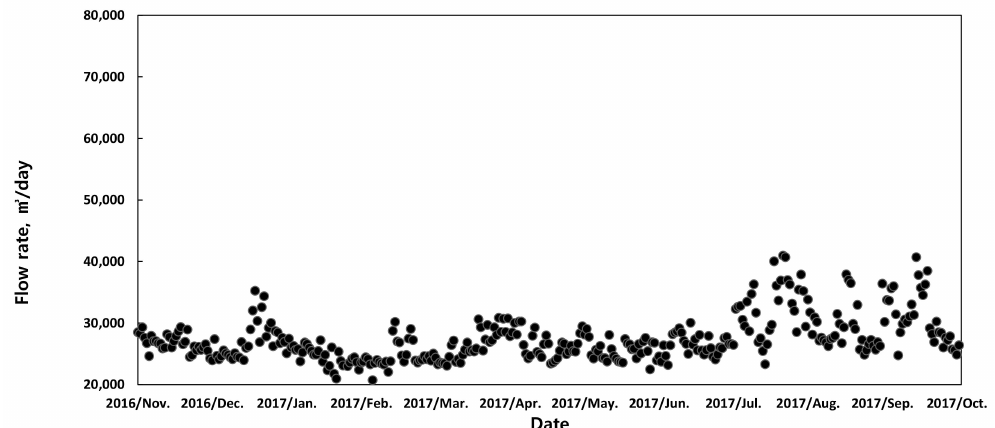
Figure 2. Flow variations of a wastewater treatment plant in city K.